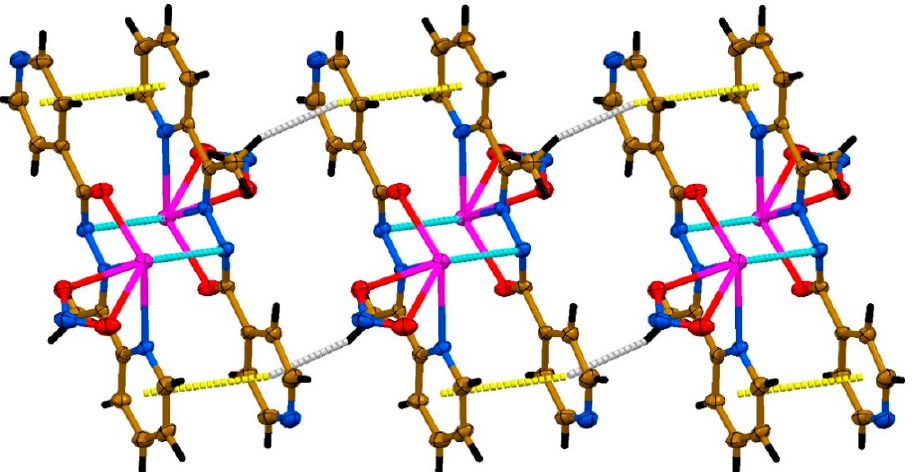
Figure 2. View on a 1D supramolecular chain in the structure of [PbL(NO 2 )] n , formed through Pb ⋯ N=C(O) tetrel bonds, π ⋯ π stacking, and C–H ⋯ π interactions (ellipsoids are drawn at 50% probability level). Color code: H = black, C = gold, N = blue, O = red, and Pb = magenta; cyan dashed line = Pb ⋯ N tetrel bond, yellow dashed line = π ⋯ π stacking interaction, and gray dashed line = C–H ⋯ π interaction.